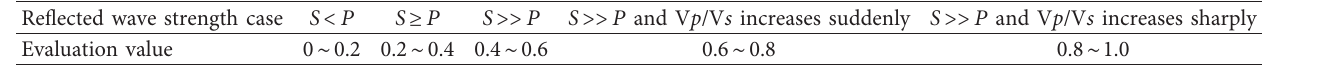
Table 2: Selection rule of groundwater development state.